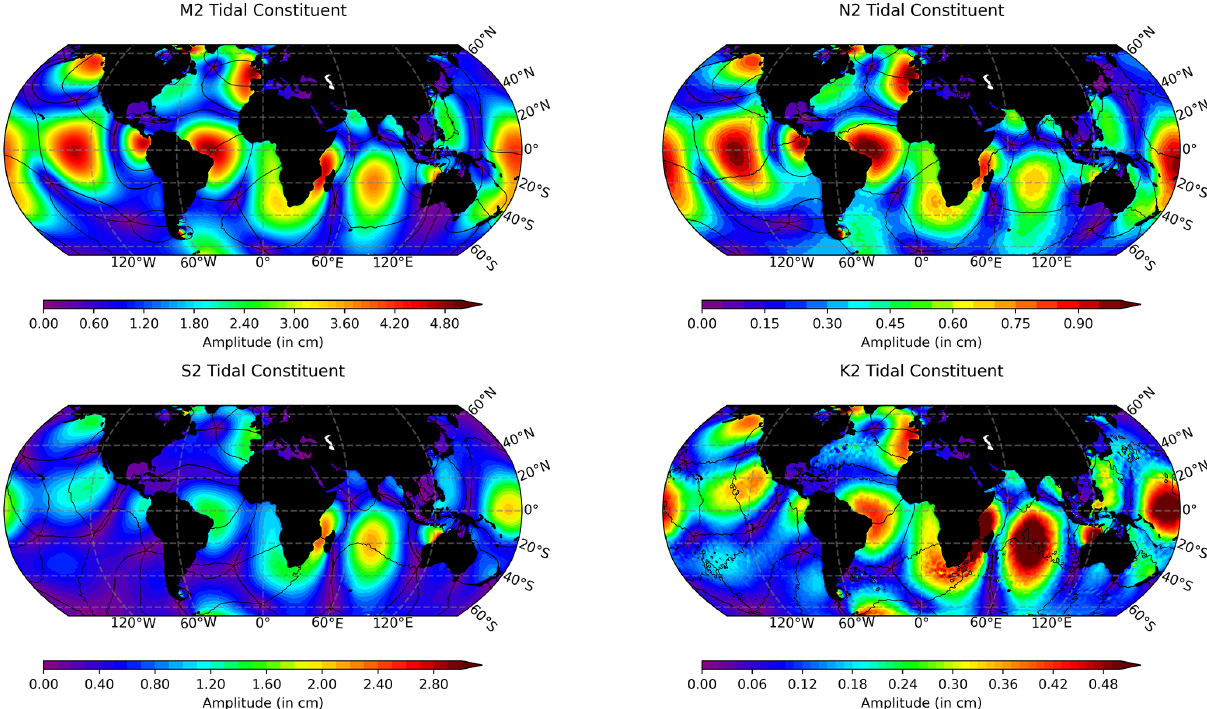
Figure 3. The amplitude (in cm) and phase (in 60 ◦ increments) of the four load tide constituents produced by the EOT20 model. It should be noted that EOT20 does not make an estimation for the load tides on land.